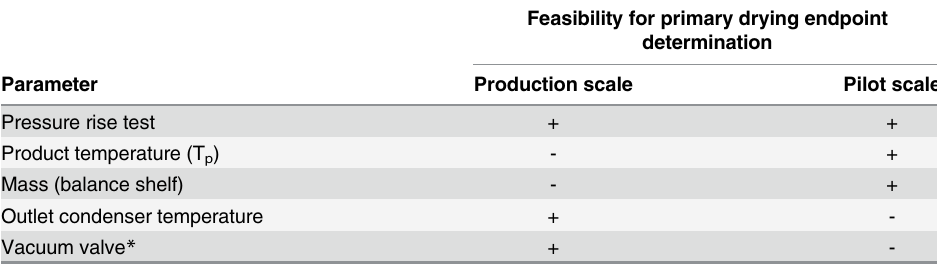
Table 2. Overview of in-process parameters at pilot and production scale that are useful for monitor- ing primary drying and primary drying endpoint